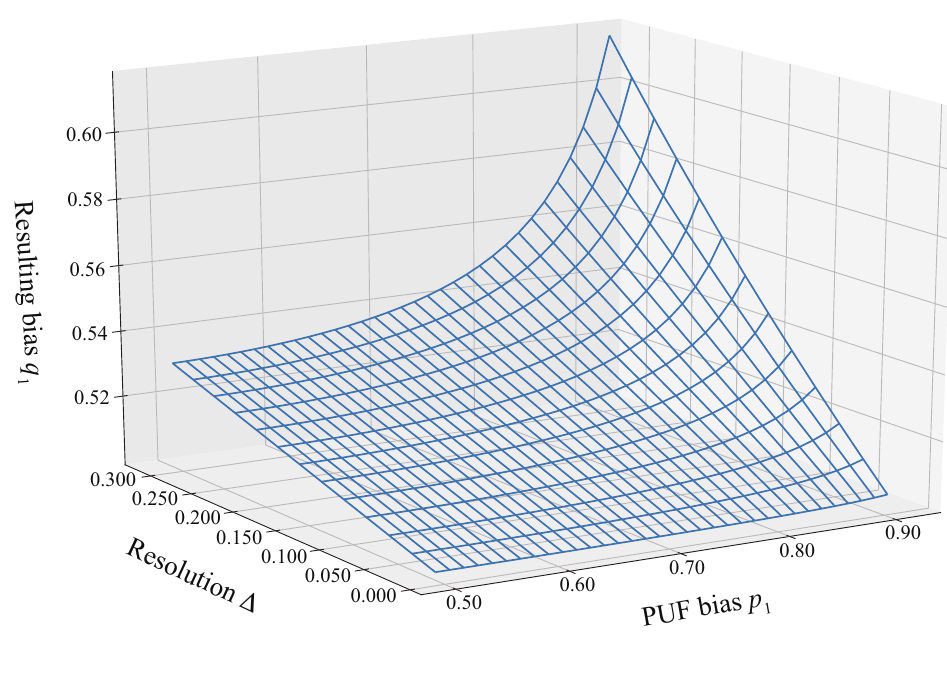
Figure 12: Graphical representation of resulting biases p 0